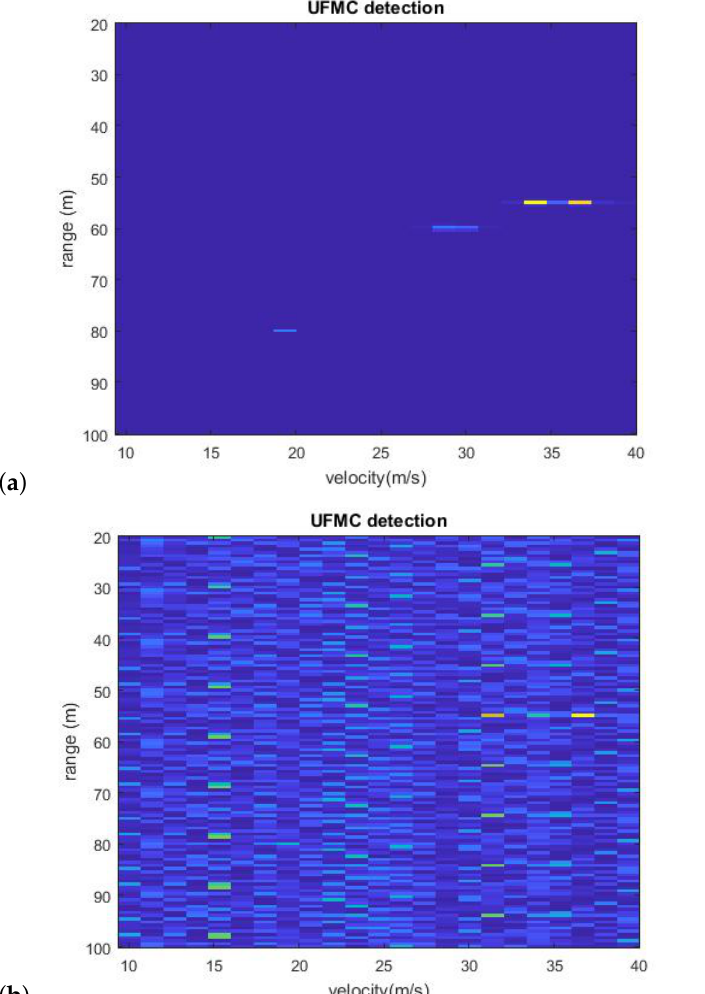
Figure 10. UFMC with fixed sub-band size Q and different filter length L : ( a ) Q = 128 and L = 16. ( b ) Q = 128 and L =